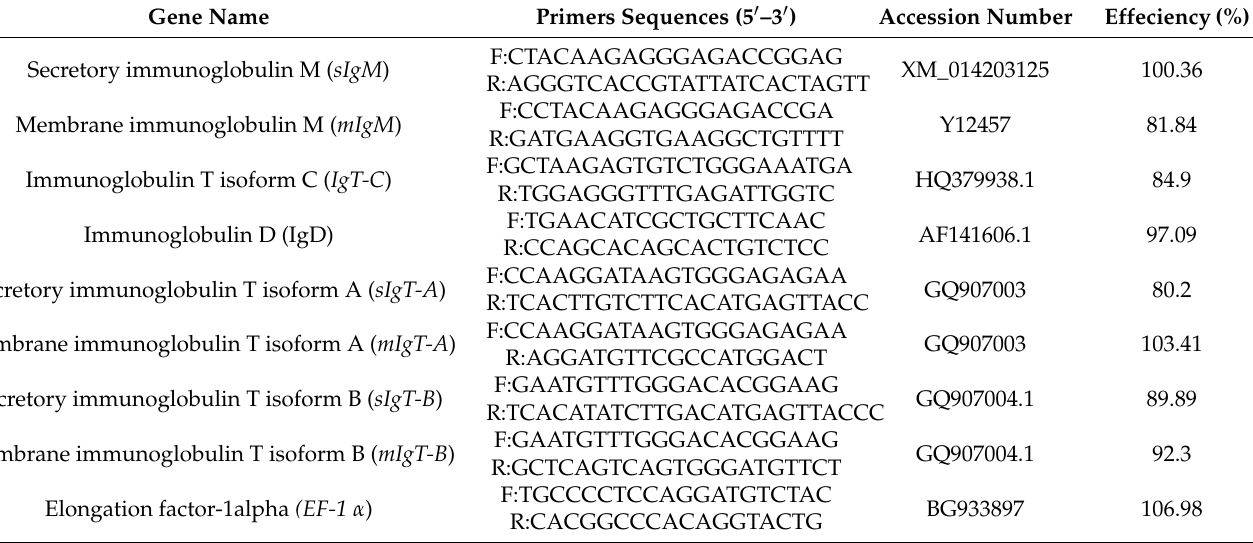
Table 1. Sequence of oligonucleotide primers used in real-time